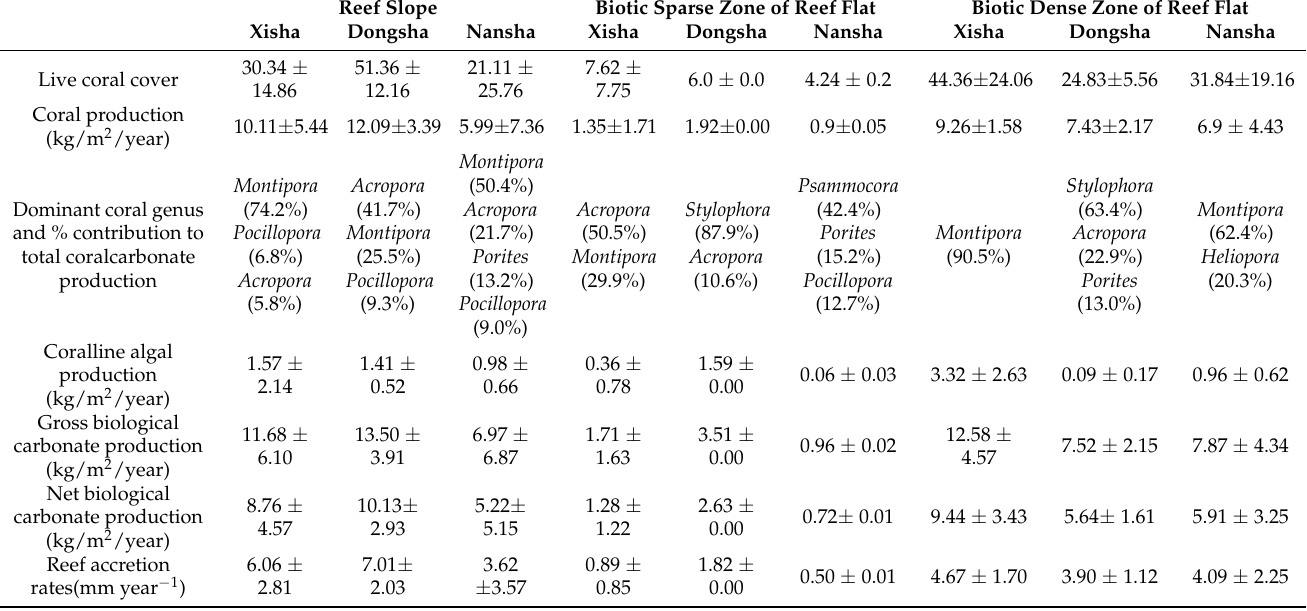
Table 3. Summary of characteristics of survey sites and of reef biological communities derived carbonate production and reef accretion rate ( ± 1 sd) calculated for 9 reefs in the Xisha Islands ( n = 35, 20 m transects); 1 reef in Dongsha Islands ( n = 17, 50 m transects on the reef flat and 25 m transects on the reef slope); and 2 reefs in Nansha Islands ( n = 10, 20 m